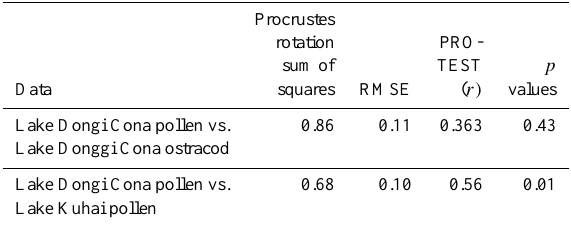
Procrustes rotation PRO- sum of TEST squares RMSE ( r) values